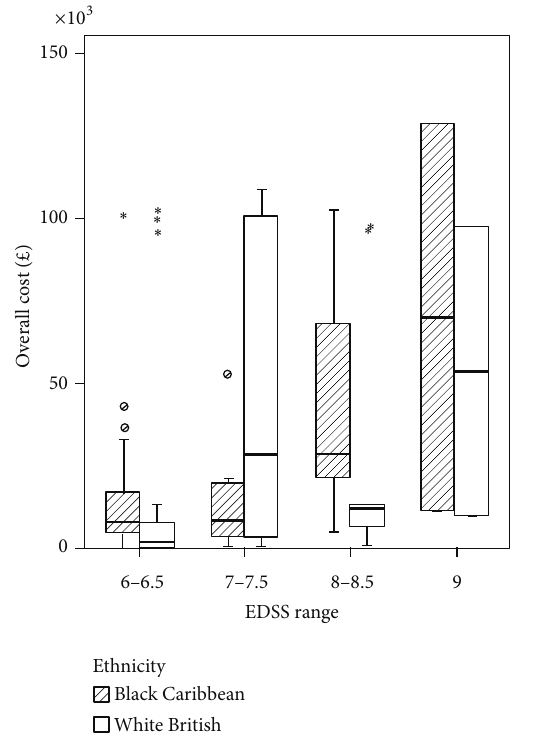
Figure 6: Box plot of overall costs for Black Caribbean and White British groups.